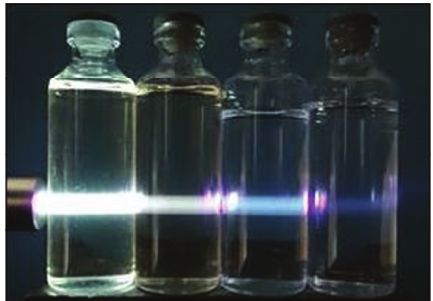
Figure 4: Visual fluorescence from RT, FT, ET, and ME (from the left to the right) excited with 5 mW at 405 nm of laser light.